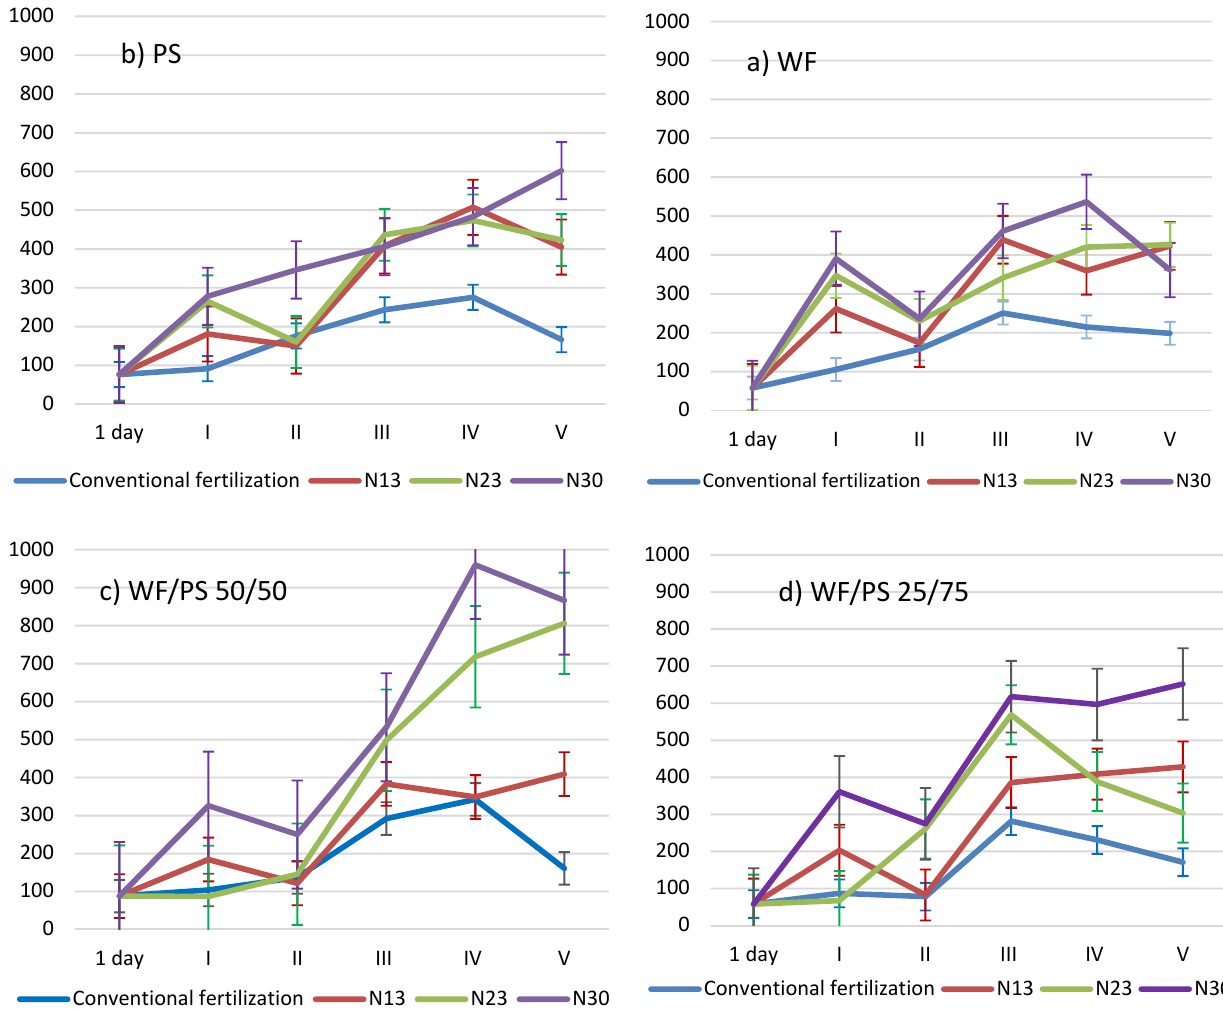
Figure 2. The influence of additional nitrogen fertilization on the variation in electrical conductivity (m S m − 1 ) in growing media during the cucumber-growing season; 1 day—1 day after transplanting; I–V—five experimental stages: 27, 39, 52, 64, and 80 days after transplanting of cucumbers into the growing media. ( a ) PS—peat substrate; ( b ) WF—wood fiber; ( c ) WF/PS 50/50—mixture of wood fiber and peat substrate 50:50 v / v ; and ( d ) WF/PS 25/75—mixture of wood fiber and peat substrate